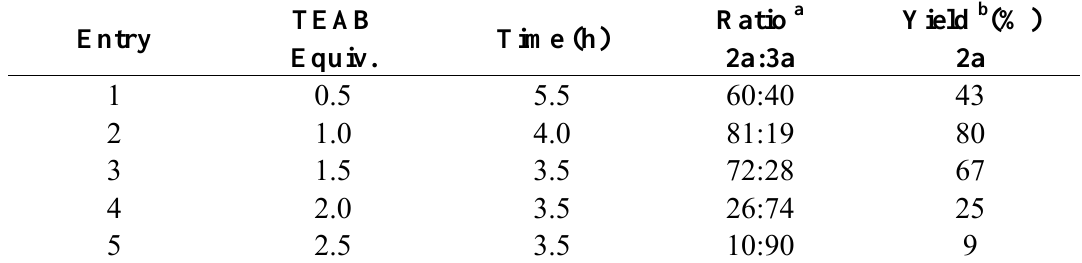
Table 5. The effect of TEAB stoichiometry on the monohydrolysis of 1a using 1.2 equivalents of NaOH.